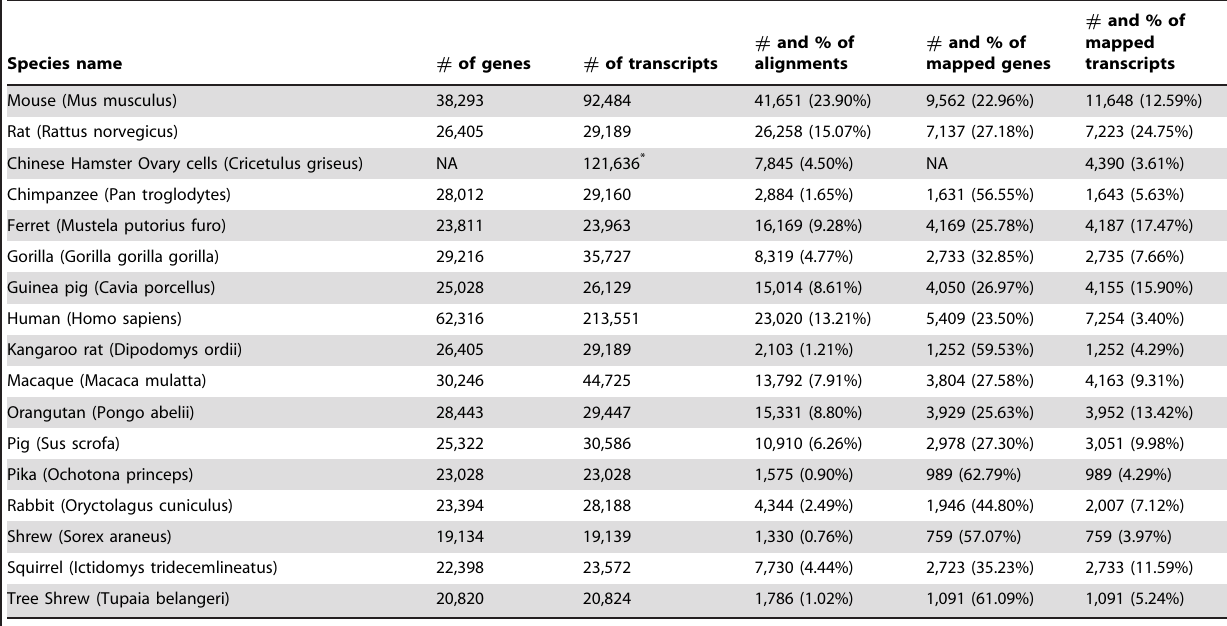
Table 1. Transcriptome references and alignment statistics.